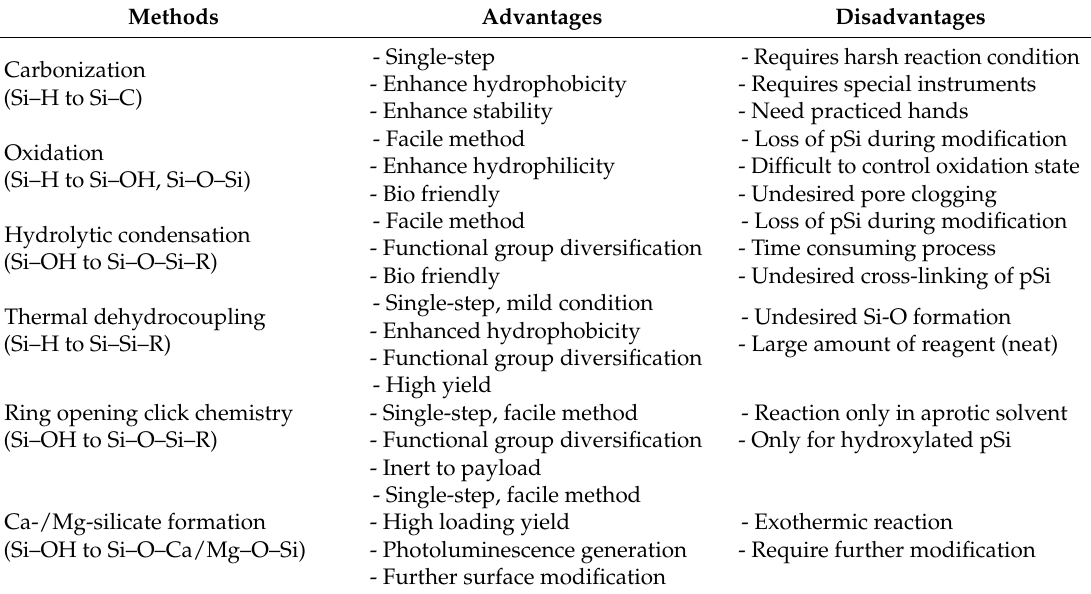
Table 1. Summary of advantages, disadvantages, and applications for each surface modification methods of pSi materials.